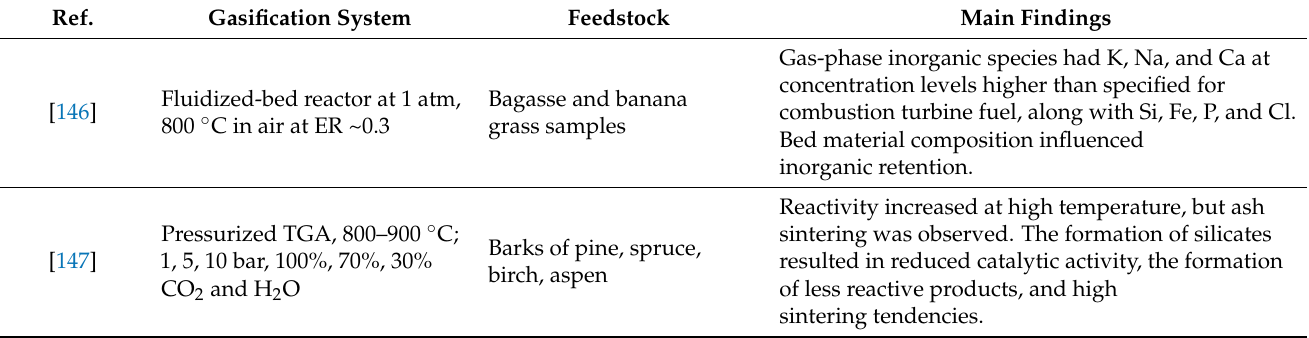
Table 4. Experimental studies investigating the effects of inherent inorganic content on the gasification of raw or treated